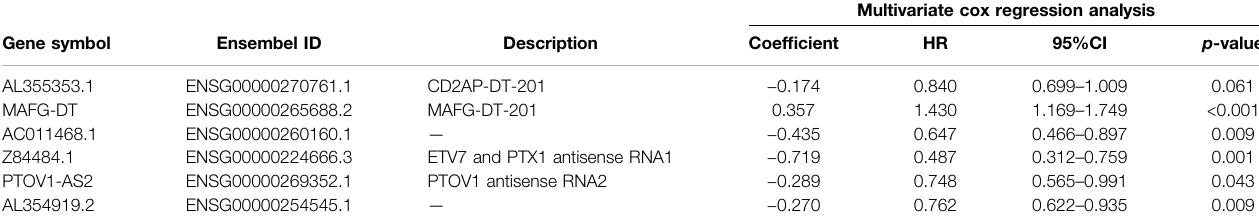
TABLE 1 | Detail information of the 6 glyco-lncRNAs.